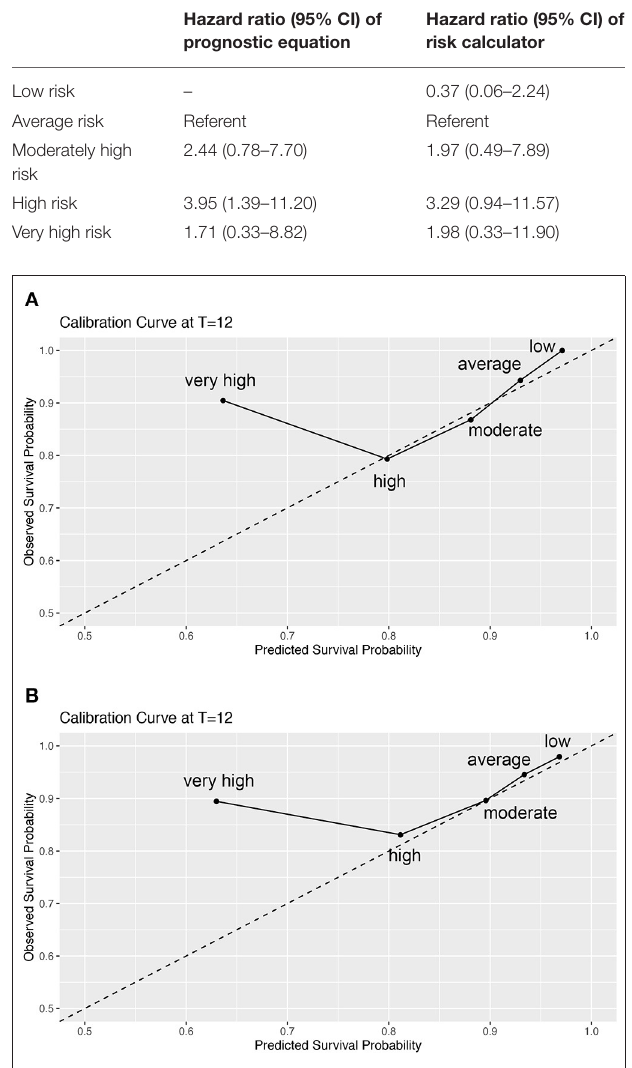
FIGURE 2 | Calibration plots in the risk groups stratified by the REVEAL prognostic equation (A) and simplified risk calculator (B) . REVEAL, Registry to Evaluate Early and Long-term Pulmonary Arterial Hypertension Disease Management.